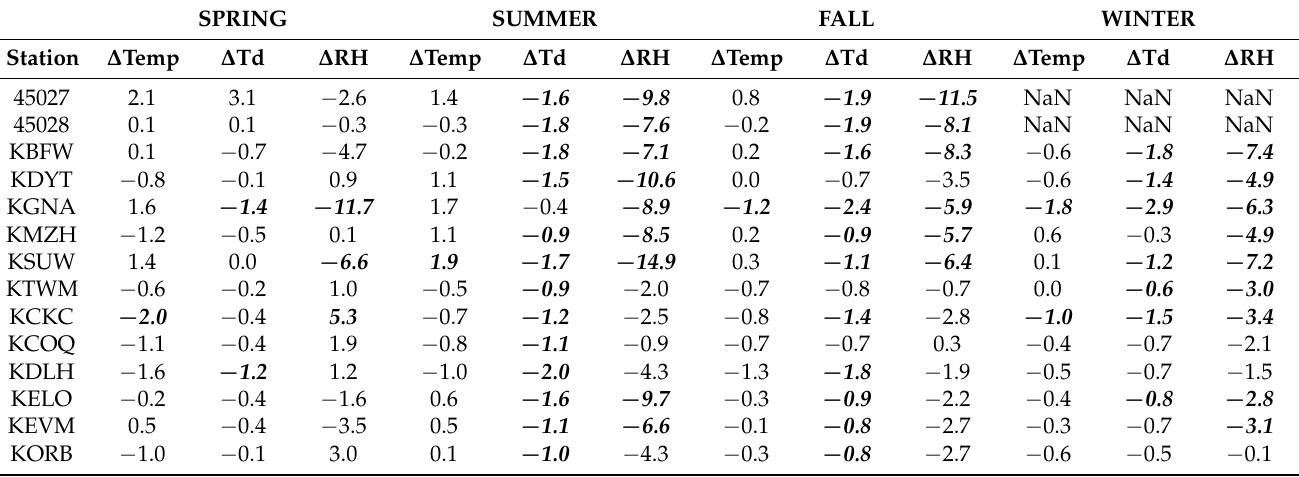
Table 4. As in Table 3 except for average temperature, dewpoint and relative humidity changes in